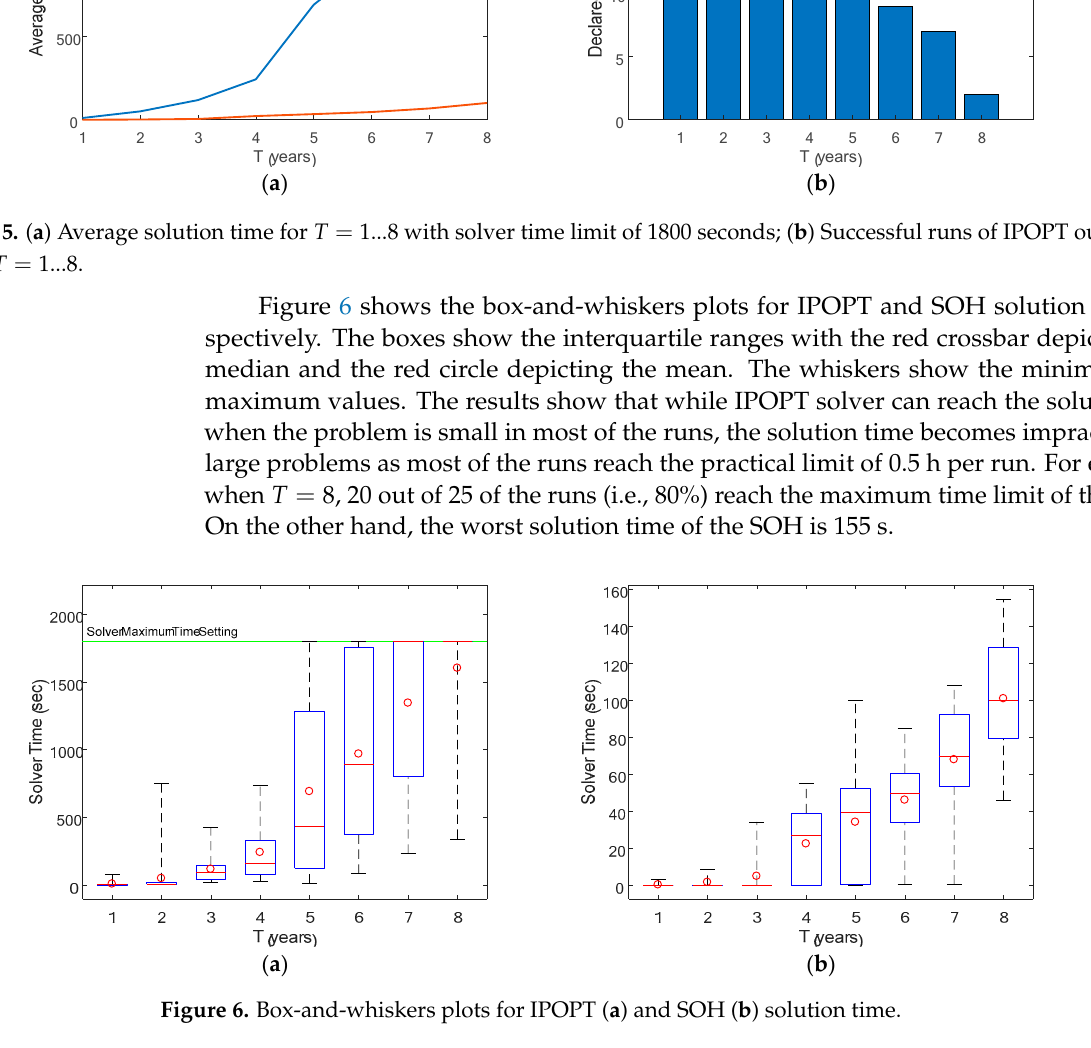
Figure 6. Box-and-whiskers plots for IPOPT ( a ) and SOH ( b ) solution time.